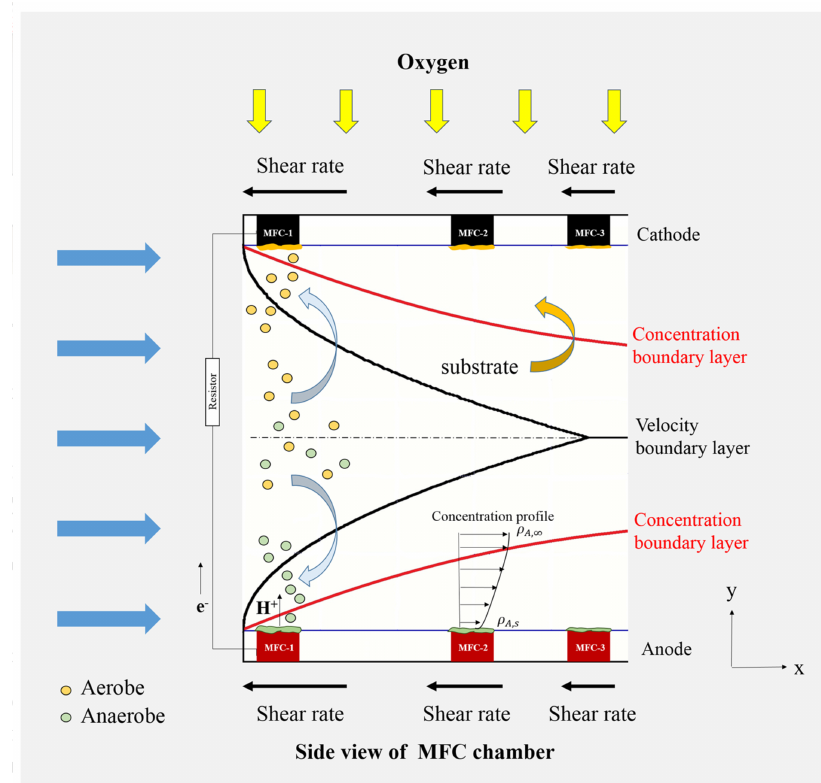
Figure 3. The mechanism of hydrodynamic boundary